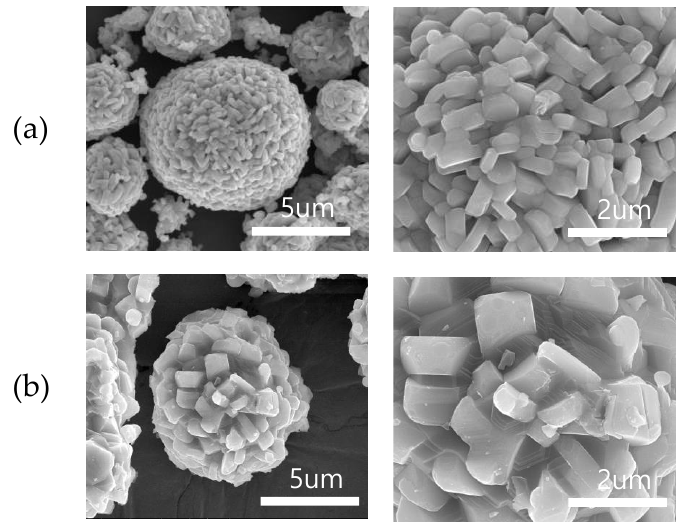
Figure 4. SEM images of the cathode active materials of ( a ) pristine NCM and ( b ) NCMS.